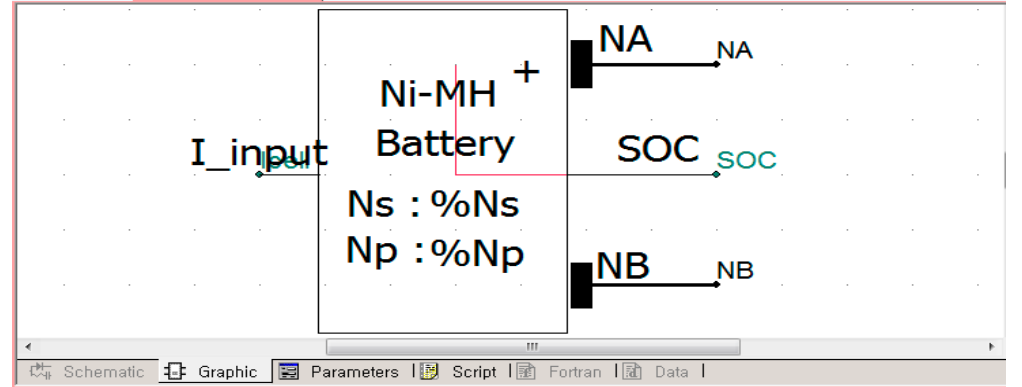
Figure 14. The components of a battery model.